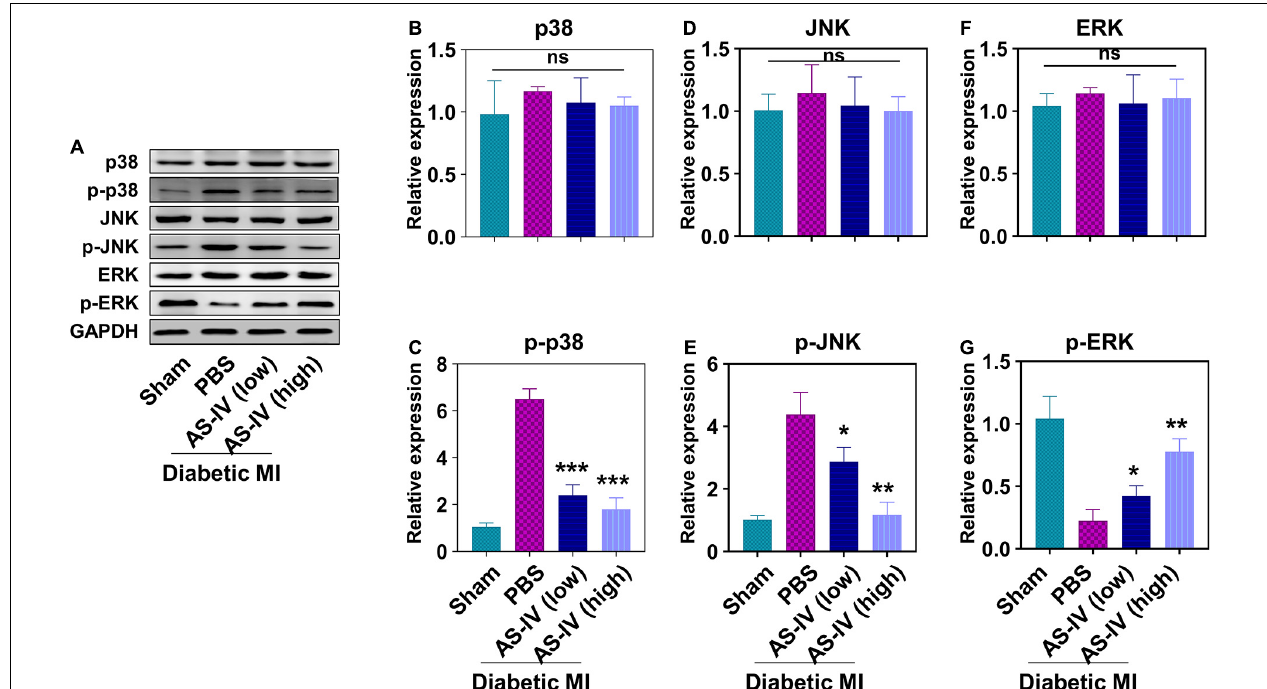
FIGURE 5 | Effect of AS-IV treatment on the activation of MAPK signaling pathway in diabetic MI hearts. (A) Representative images of Western blot of p38, p-p38, JNK, p-JNK, ERK, and p-ERK. The protein expressions of p38 (B) , p-p38 (C) , JNK (D) , p-JNK (E) , ERK (F) , and p-ERK (G) were quantified by Image J software. Data represent means ± SD. ns, no significant difference, * p < 0.05; ** p < 0.01; *** p < 0.001, versus PBS group, normalized to GAPDH level, n = 3 biologically independent